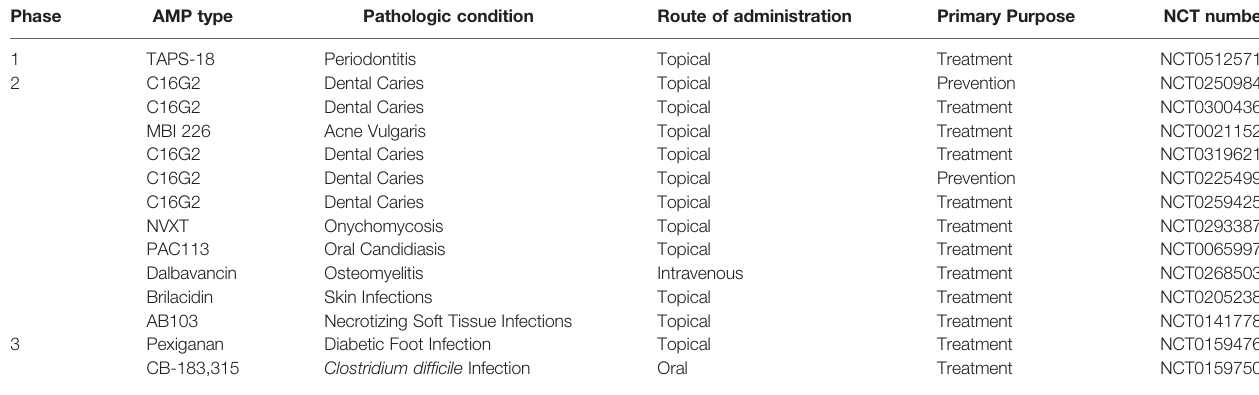
TABLE 2 | Clinical trials of AMP administration in infectious